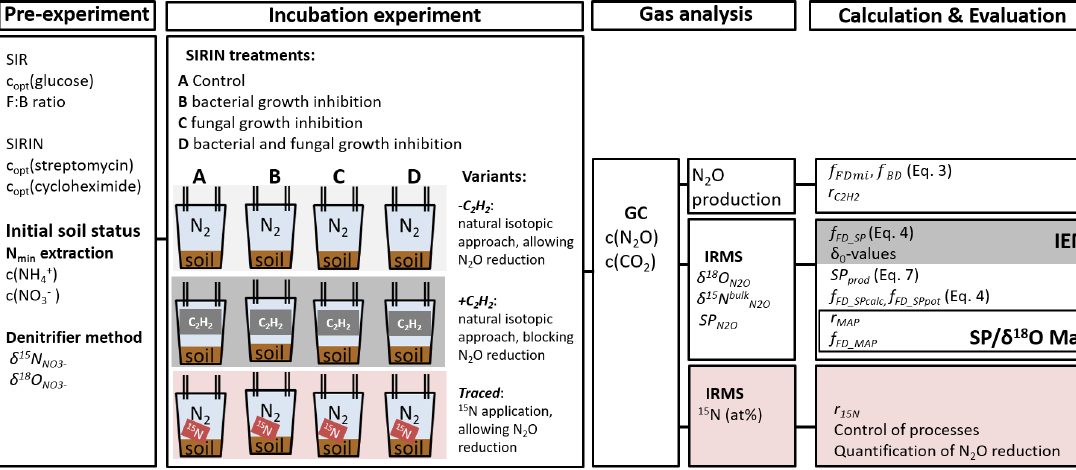
Figure 1. The methodical approach comprised a pre-experiment with substrate-induced respiration (SIR) to estimate the optimal glucose concentration ( c opt (glucose)) and the fungal-to-bacterial ratio in the soil ( F : B ratio) and the substrate-induced respiration with selective inhibition approach (SIRIN) to determine the optimal inhibitor concentration ( c opt (streptomycin and c opt (cycloheximide)). The initial soil status, i.e. ammonium and nitrate concentration of the soil ( c (NH + ) and c (NO − ), respectively), was measured in N min extracts, and the 4 3 isotopic signature of soil NO − was analysed by the denitrifier method. The incubation experiment comprised the SIRIN approach with three 3 experimental variants: without acetylene ( − C 2 H 2 ), with C 2 H 2 ( + C 2 H 2 ) and without C 2 H 2 but with 15 N labelled NO − (traced), while NO − 3 3 with natural isotopic composition was added to the other two variants. Produced gas was analysed for its concentration (c(CO 2 ) and c(N 2 O)) using gas chromatography (GC), and N 2 O was further analysed by isotope ratio mass spectrometry (IRMS) for its isotopic composition. Please refer to Sect. 2 for more